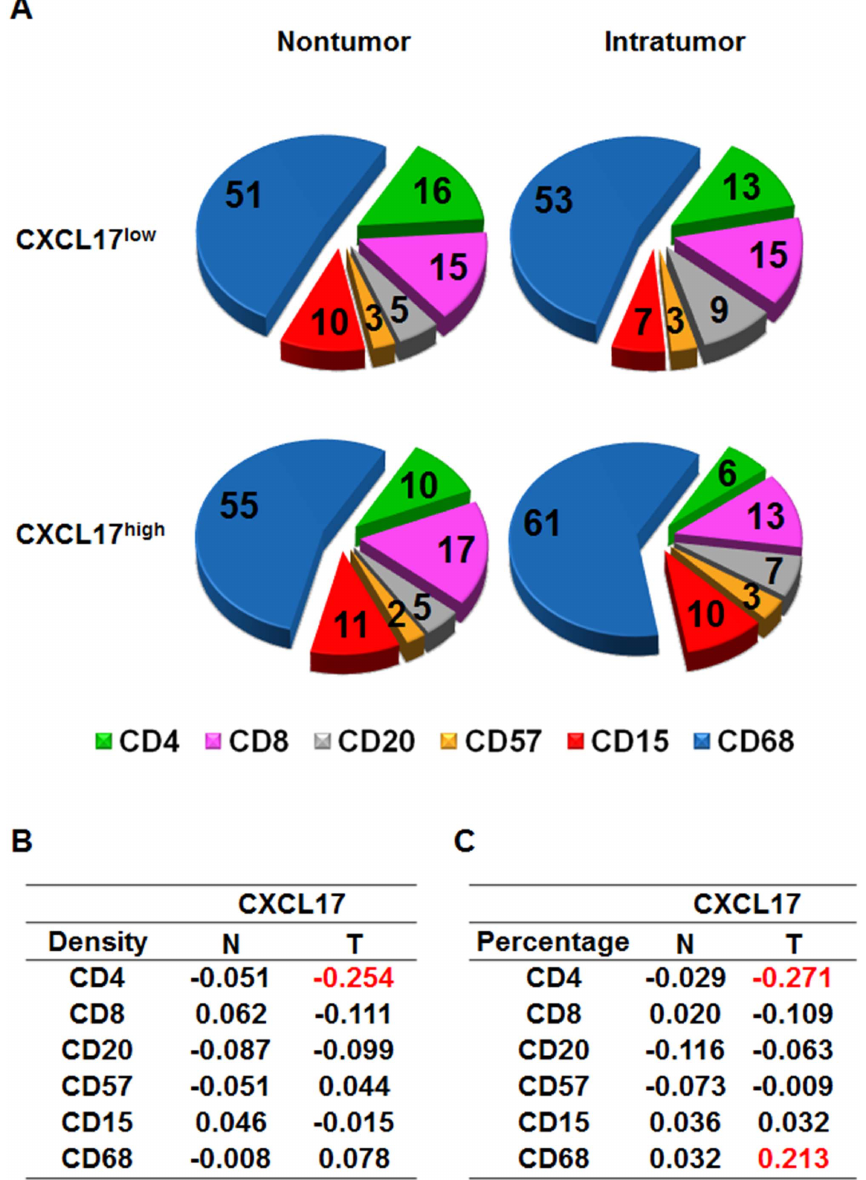
Figure 3. Composition of immune infiltrates according to CXCL17 expression. (A) Pie charts summarized the percentages of nontumor- infiltrating (N, left) and tumor-infiltrating (T, right) CD4, CD8, CD20, CD57, CD15, and CD68 cells in CXCL17 low and CXCL17 high groups. (B, C) Correlation coefficients between the density or percentage of CXCL17 and the density of each immune cell subset were shown.